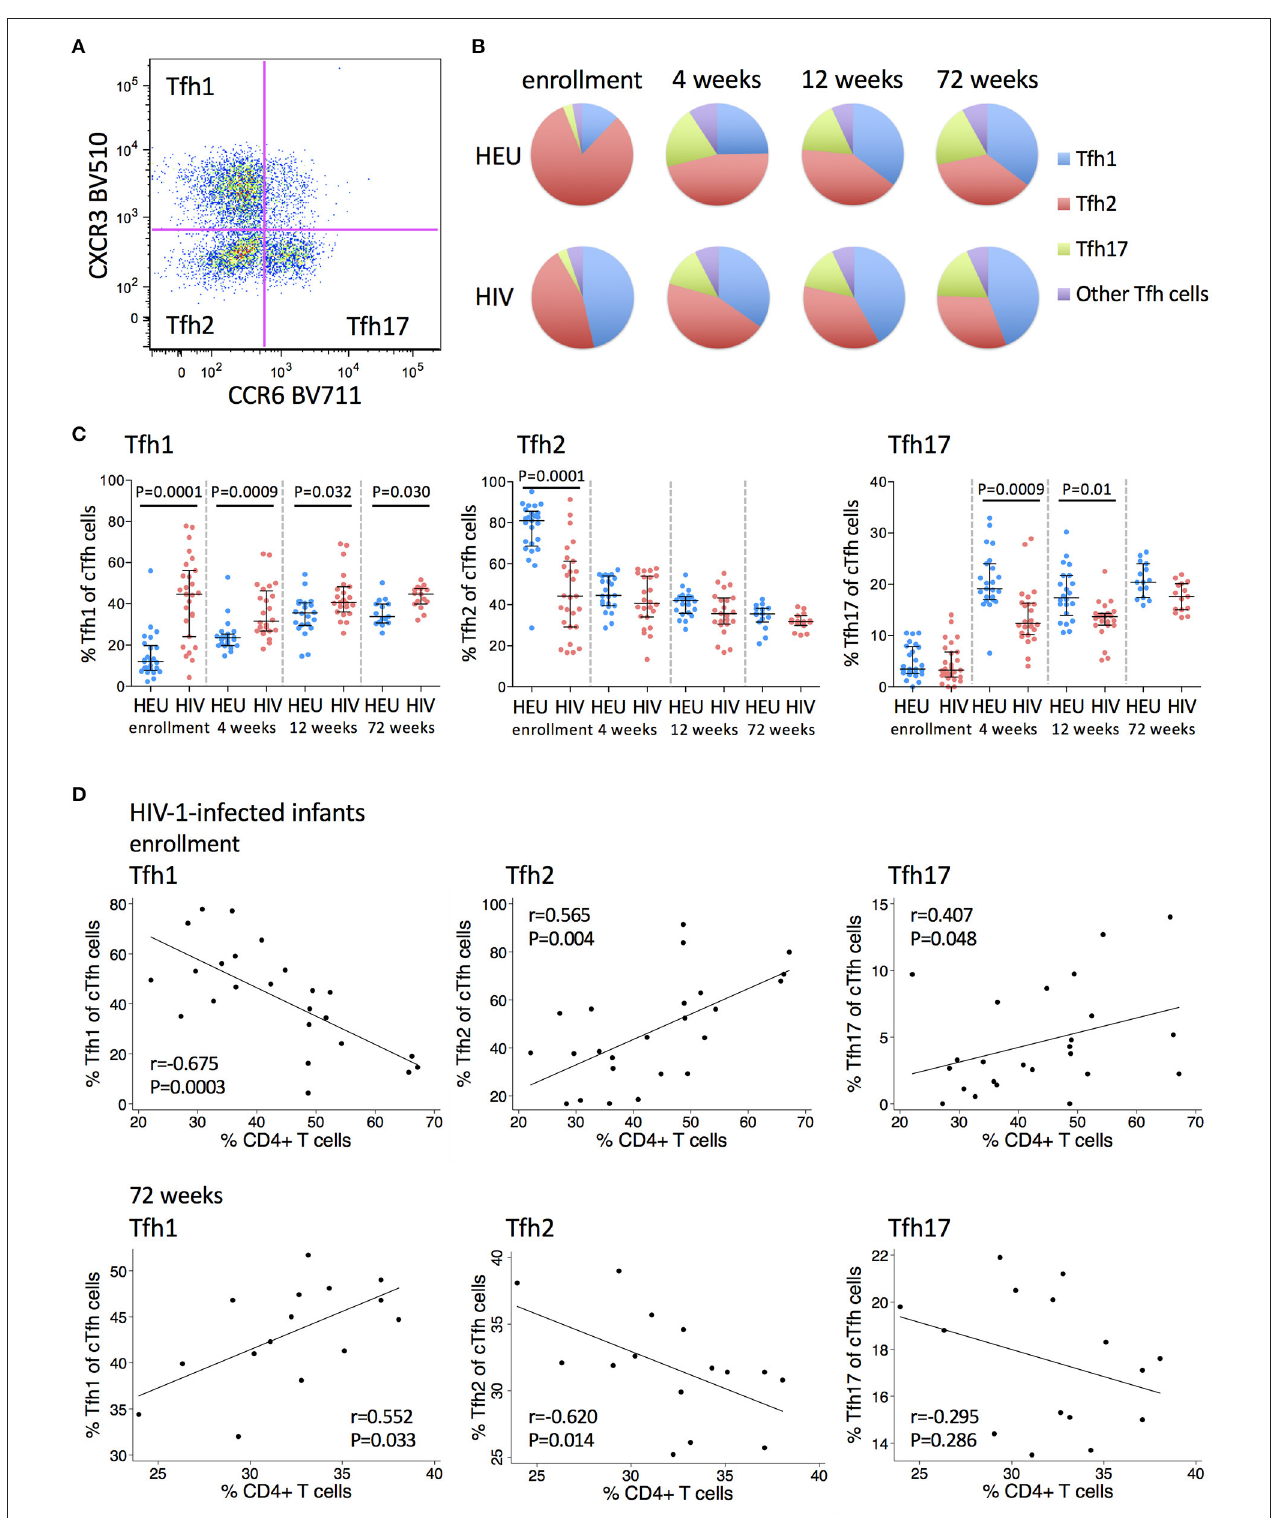
FIGURE 2 | Frequencies of Tfh1 cells are increased and frequencies of Tfh2 and Tfh17 cells are decreased in HIV-1-infected infants. (A) A pseudocolor plot showing cTfh cells that have been subdivided into Tfh1, Tfh2 and Tfh17 subsets based on their CXCR3 and CCR6 expression. (B) The distribution of Tfh1 (blue), Tfh2